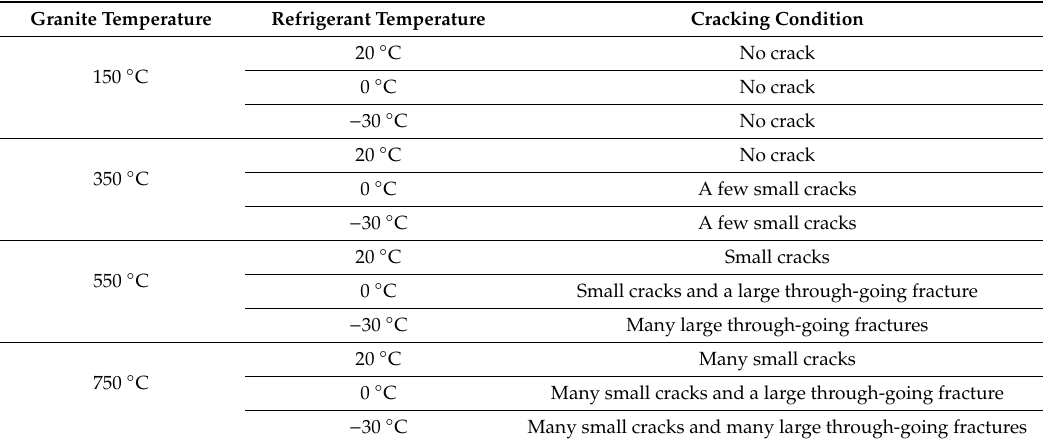
Table 4. Description of Cracking of Granite.